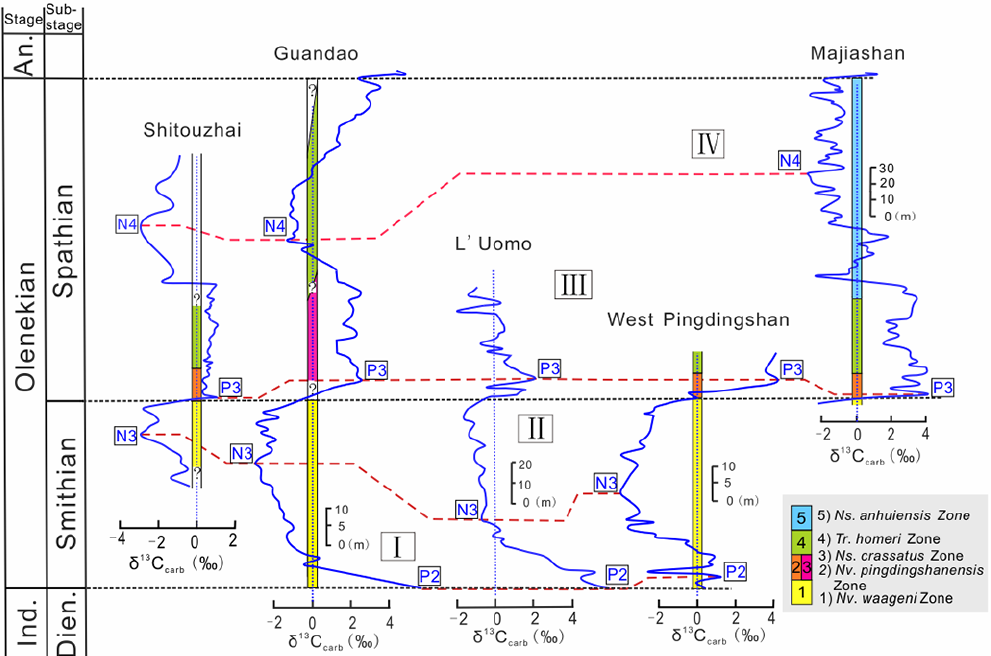
Figure 2. Biostratigraphic and C-isotopic correlations of the Shitouzhai section with other Smithian–Spathian sections. Note that Intervals I– IV of δ 13 C carb profiles are recognizable globally. The standard notation (P2, P3, N3, and N4) for positive and negative C-isotope excursions of the Early Triassic is according to Song et al. (2013). Data for the Guandao, West Pingdingshan, and Majiashan sections are from Tong et al. (2007) and from Horacek et al. (2007) for the L’Uomo section. The different color columns represent corresponding conodont zones from old to young in an ascending order. Question marks represent problematic conodont biozones in need of further study in the Shitouzhai and Guandao sections. An., Ind., and Dien. stand for Anisian, Induan, and Dienerian,